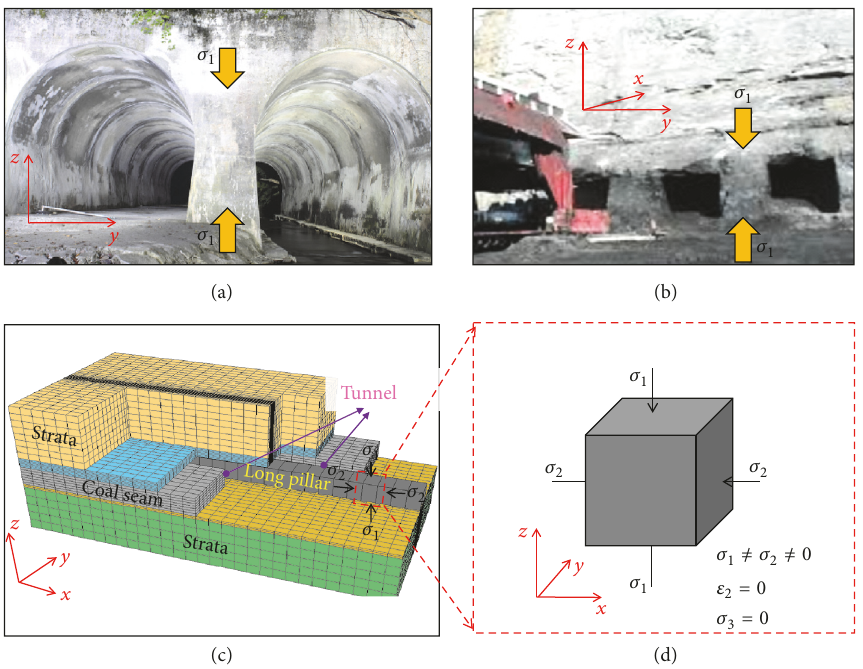
Figure 1: Typical pillars under plane-strain biaxial stress state (PSBSS). (a) Rock pillar between adjacent tunnels; (b) coal pillar in highwall mining system; (c) coal pillar in longwall mining system; (d) a block under plane-strain biaxial compression stress state.